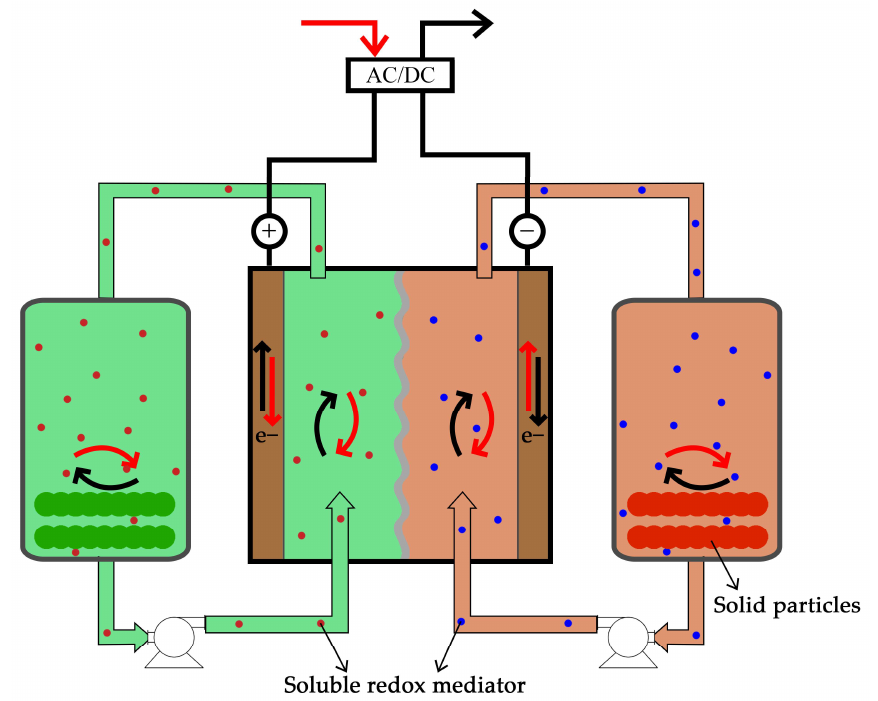
Figure 12. Representation of a semi-solid RFB with redox mediator. Adapted from Ref. [20], Copy- right 2015, MDPI.